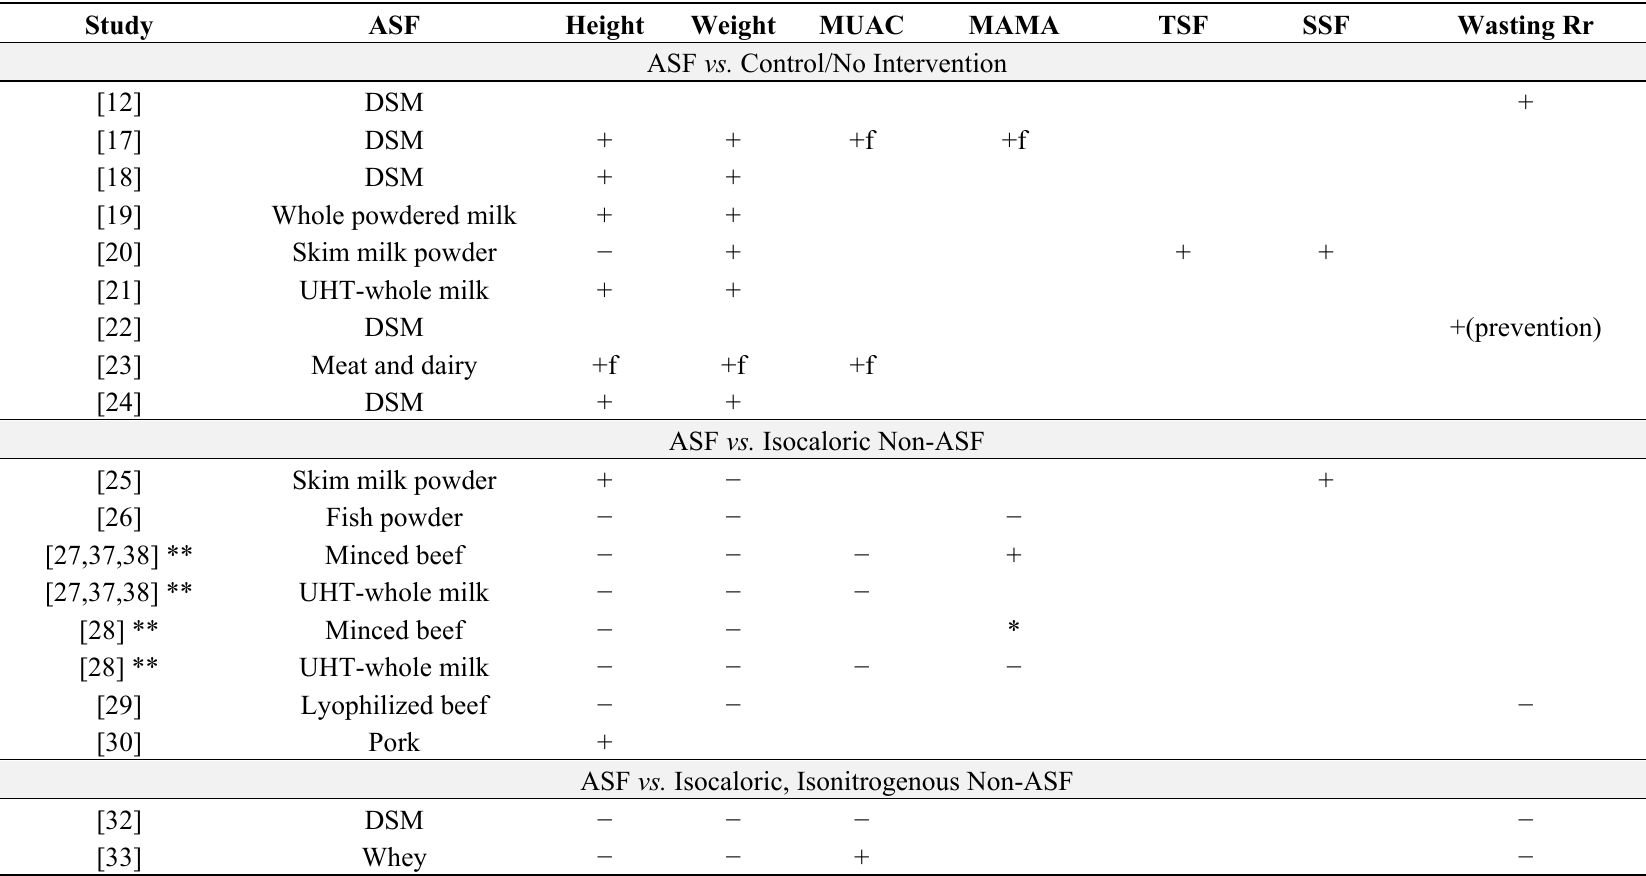
Table 5. Summary of interventions: did the animal source food (ASF) have a better growth outcome than the non-ASF?